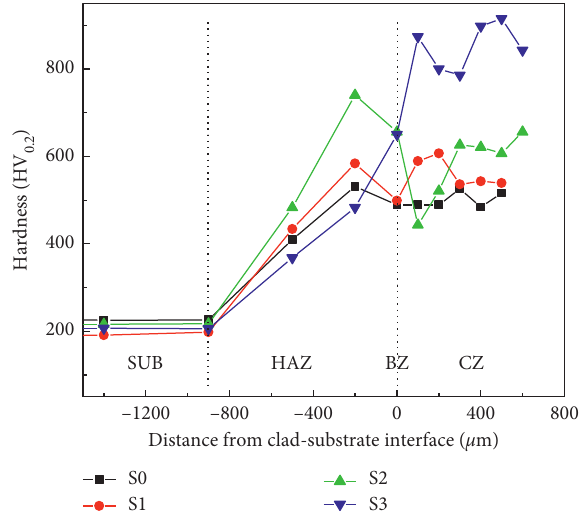
Figure 10: Microhardness distribution of cross section of S0, S1, S2, and S3